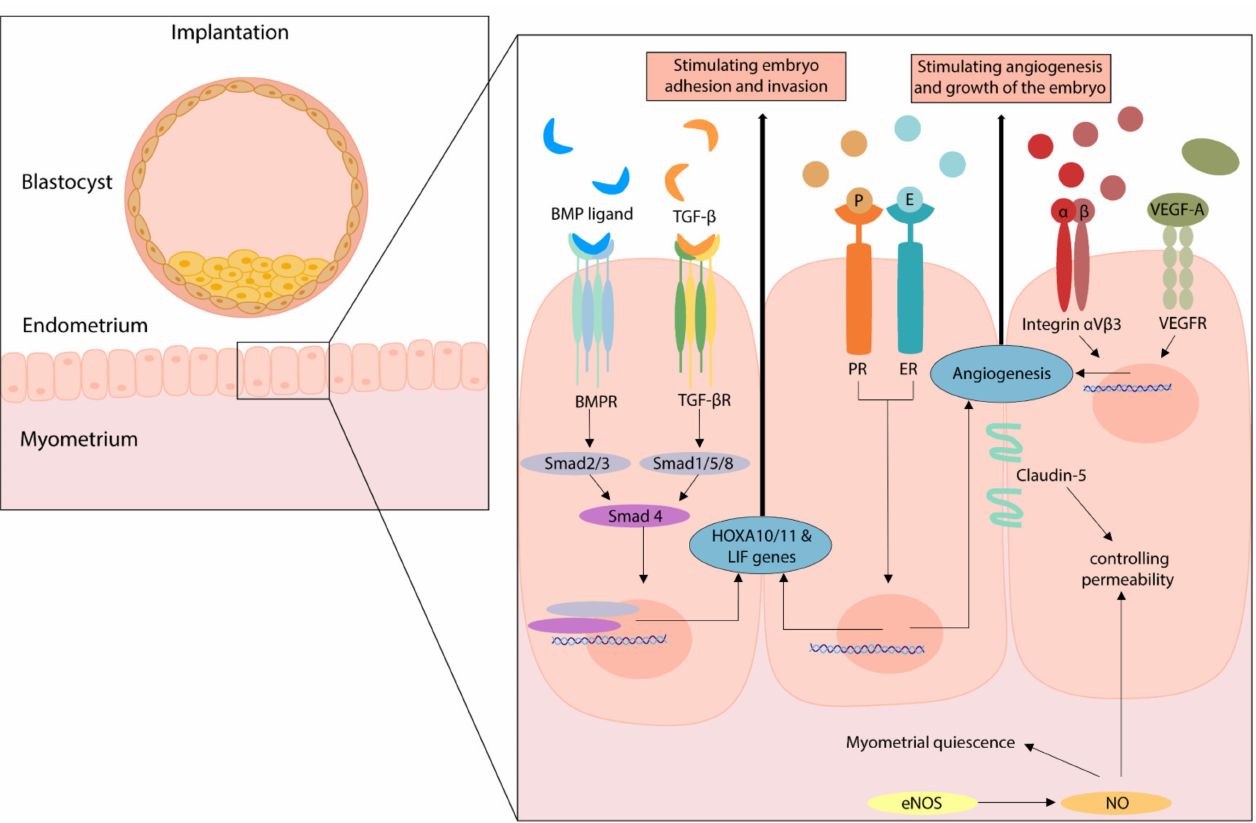
Figure 4. The effect of several angiogenic pathways on implantation. Figure legend: BMP(R): Bone morphogenetic protein (receptor); EC: endothelial cell; E(R): Estrogen (receptor); eNOS: endothelial nitric oxide synthase; LIF: leukemia inhibitory factor; NO: nitric oxide; P(R): progesterone (receptor); Smad: Suppressor of mothers against decapentaplegic; TGF- β : transforming growth factor; TGF- β (R): transforming growth factor- β (receptor); VEGF-A/R: vascular endothelial growth